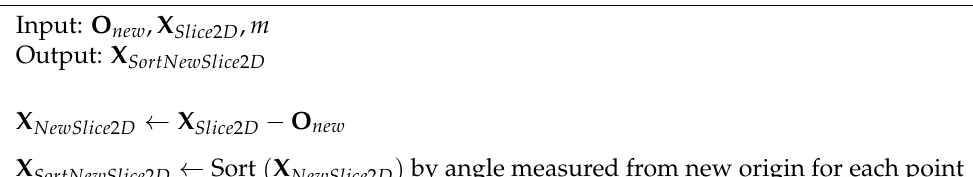
Algorithm A9 Function: Switch the origin to the new